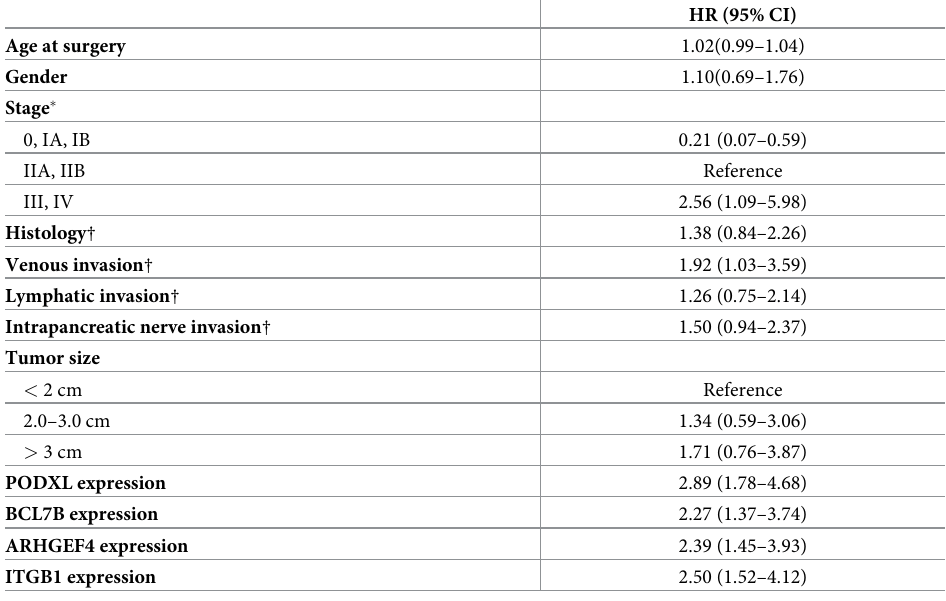
Table 4. Univariate analysis using the Cox proportional hazards regression